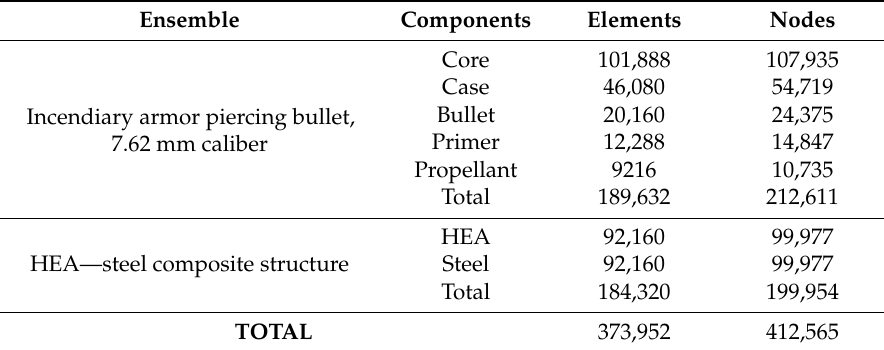
Table 1. Structure of finite element